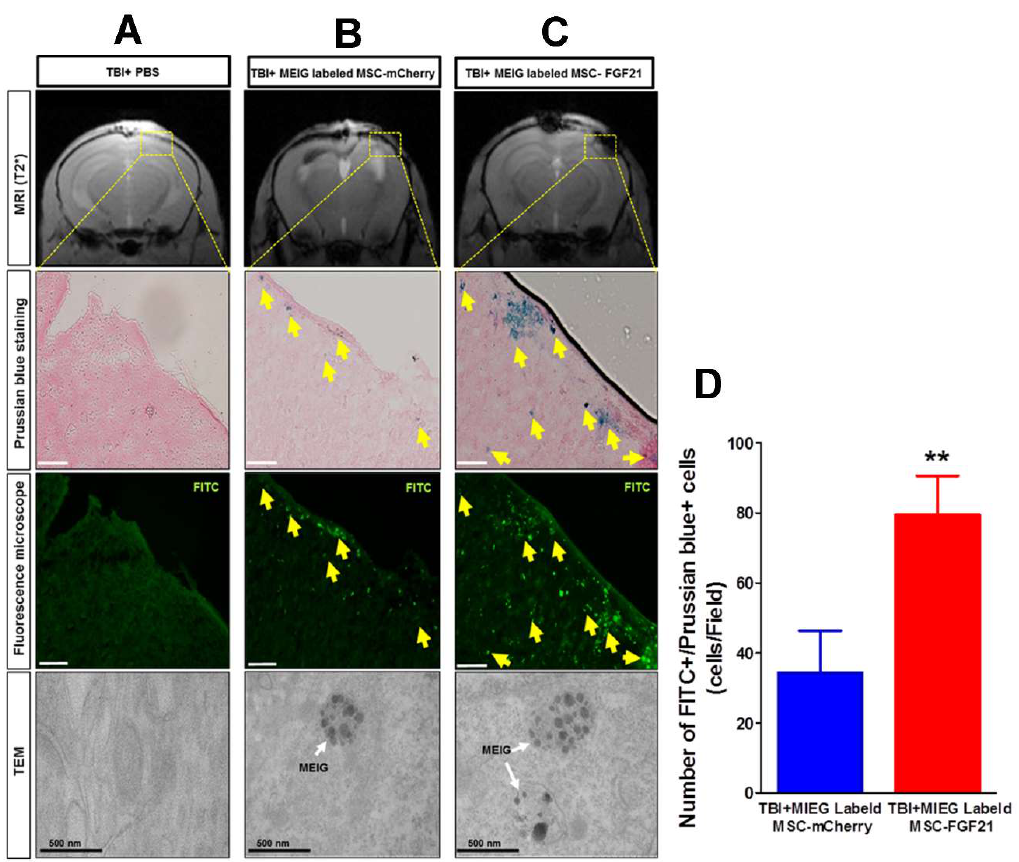
Figure 7. Ex vivo histological analysis. ( A – C ) Prussian blue staining combined with Fluorescein isothiocyanate (FITC) reactivity 14 days post-transplantation. ( C ) In MSC-FGF21-treated animals, the iron nanoparticles (blue) in Prussian Blue staining and FITC reactivity that represent MIEG are overlapped and located at the position of MRI hypointensities at the injury site. Similarly, in MSC-mCherry-treated animals, the iron nanoparticles are located to the same areas as FITC and MRI hypointensities and were less pronounced compared to MSC-FGF21 ( B ). ( D ) Quantative analysis of the Prussian blue and FITC positive cells numbers at the injury site ( A ) In PBS-treated animals, iron staining, FITC reactivity, and MRI hypointensities are almost absent at injury site. TEM imaging was used to further investigate the intracellular iron presence at the injury site for all groups (lower panel). The dotted boxed represents the injury site; yellow arrows show Prussian Blue and FITC-positive cells; white arrows show the intracellular MIEG at the injury site. Scale bar is 50 mm unless stated otherwise. Quantified data are mean ± SEM ( n = 4 animals per group) of. ** p <0.01 compared between MIEG labeled MSC-FGF21 and MIEG labeled MSC-mCherry treated TBI animals.